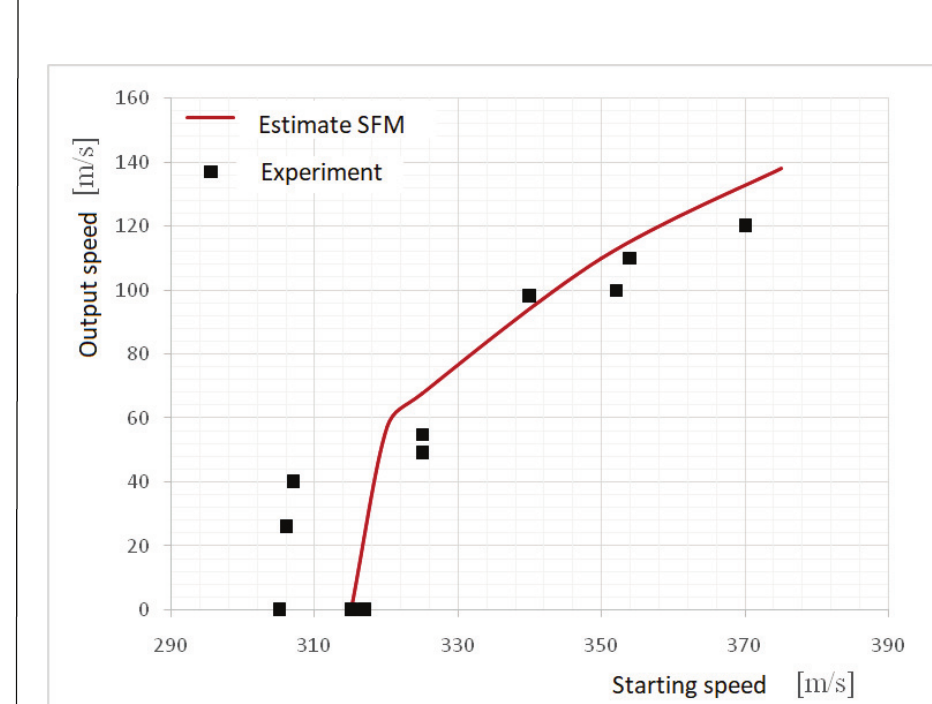
Figure 11 – Analysis of the SFM by a blunt projectile for a plate with a thickness of 20 mm Рис . 11 – Анализ SFM тупоконечным снарядом на плиту , толщиной 20 мм Слика 11 – Анализа СФМ тупим пројектилом за плочу дебљине 20